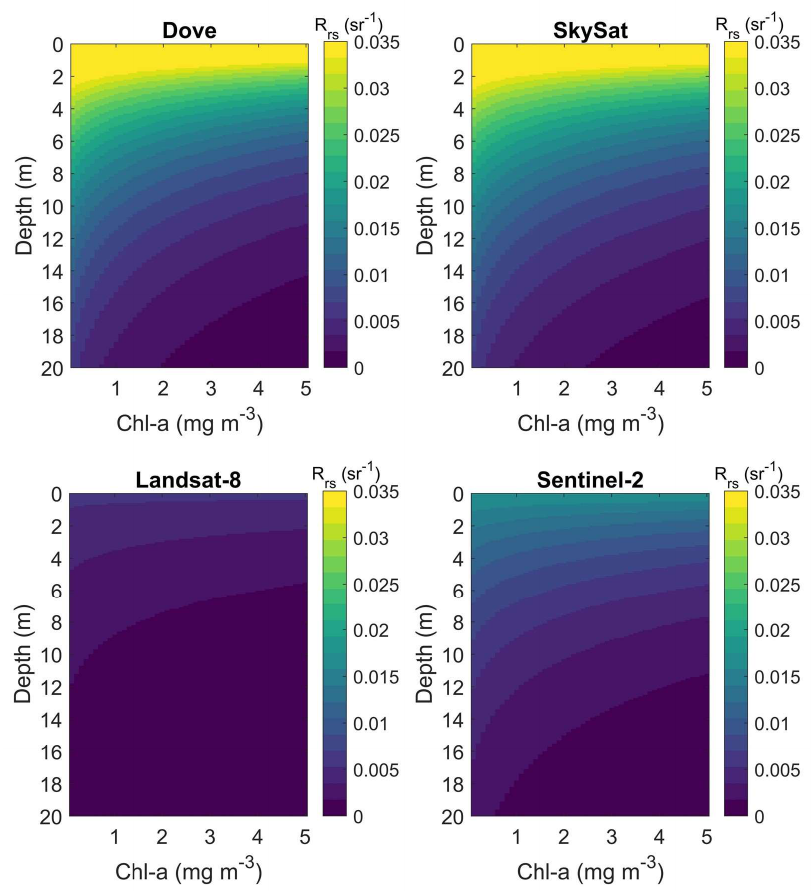
Figure 9. Di ff erences in remote sensing reflectance between bleached and live coral at 4 m × 4 m Figure 9. Differences in remote sensing reflectance between bleached and live coral at 4 m x 4 m simulated ground sampling distance (pixel simulated ground sampling distance (pixel size).